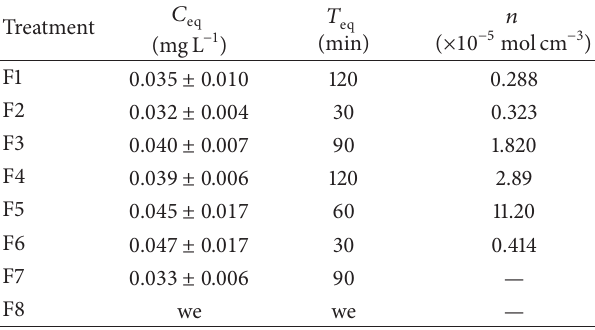
Table 5: Adsorption equilibrium parameters in dark phase control films formed using the 2 3 experimental design. with TiO 2